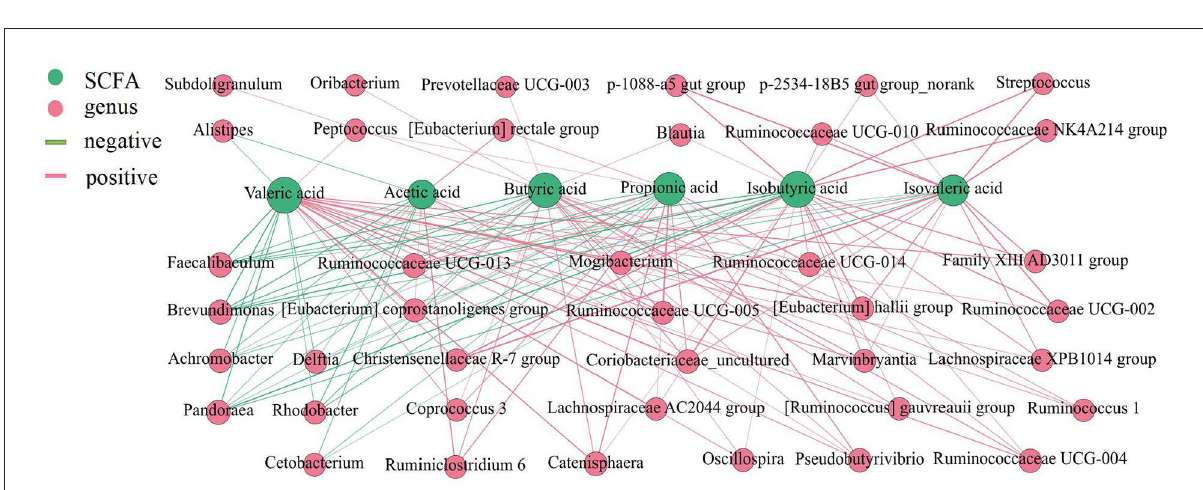
with the content of a variety of amino acids, indicating a robust contribution to the synthesis of amino